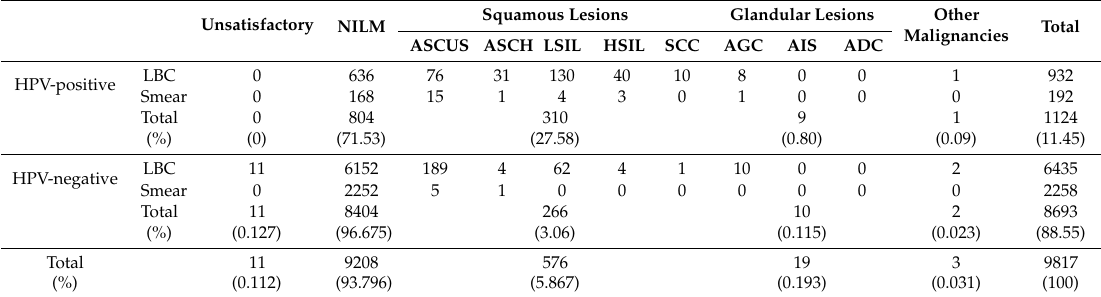
Table 9. HPV infection and cytologic diagnosis in the BD Onclarity ™ HPV assay group. Unsatisfactory